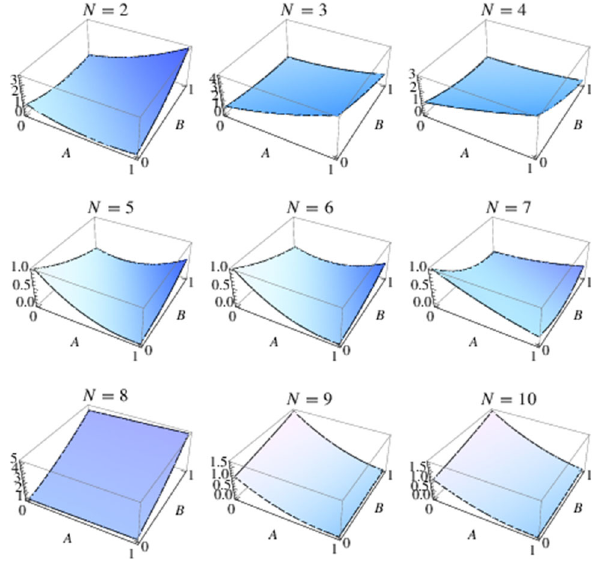
( log ) Fig. 1 The ratio E ∗ / E ∗ (Eqs. (22) and (20)) as a function of the amplitudes A and B , for N = 2 , 3 ,...,